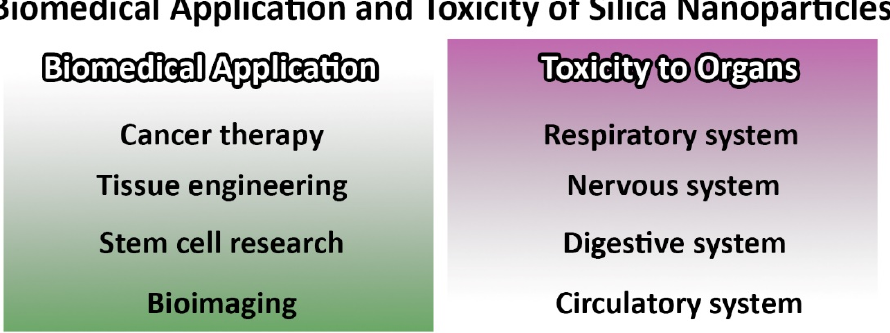
Figure 2. Biomedical applications and toxicity of mesoporous silica nanoparticles (MSNs).